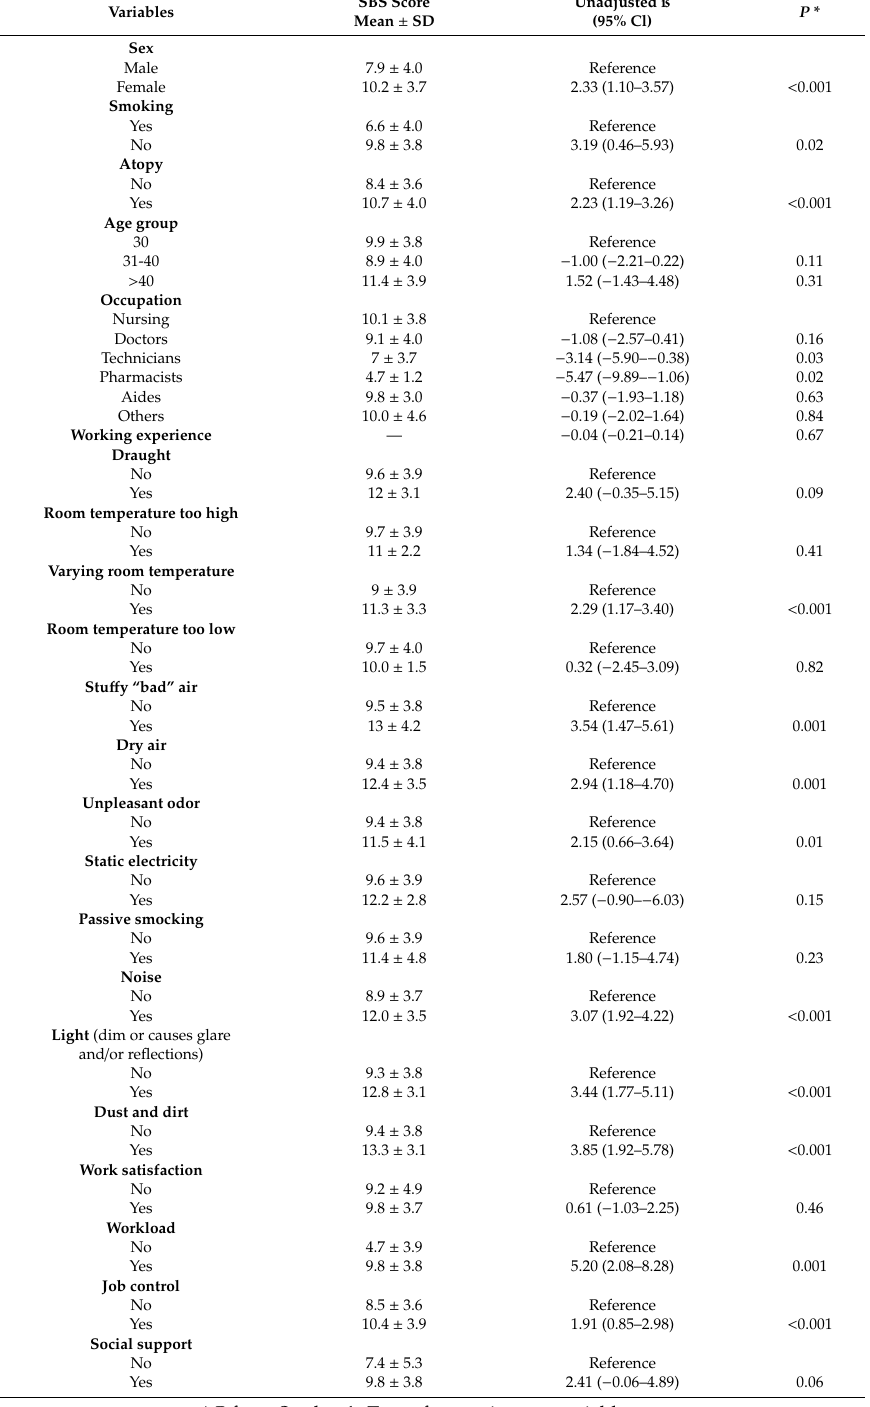
Table 3. Univariate analyses of correlates of SBS score among healthcare workers (n =